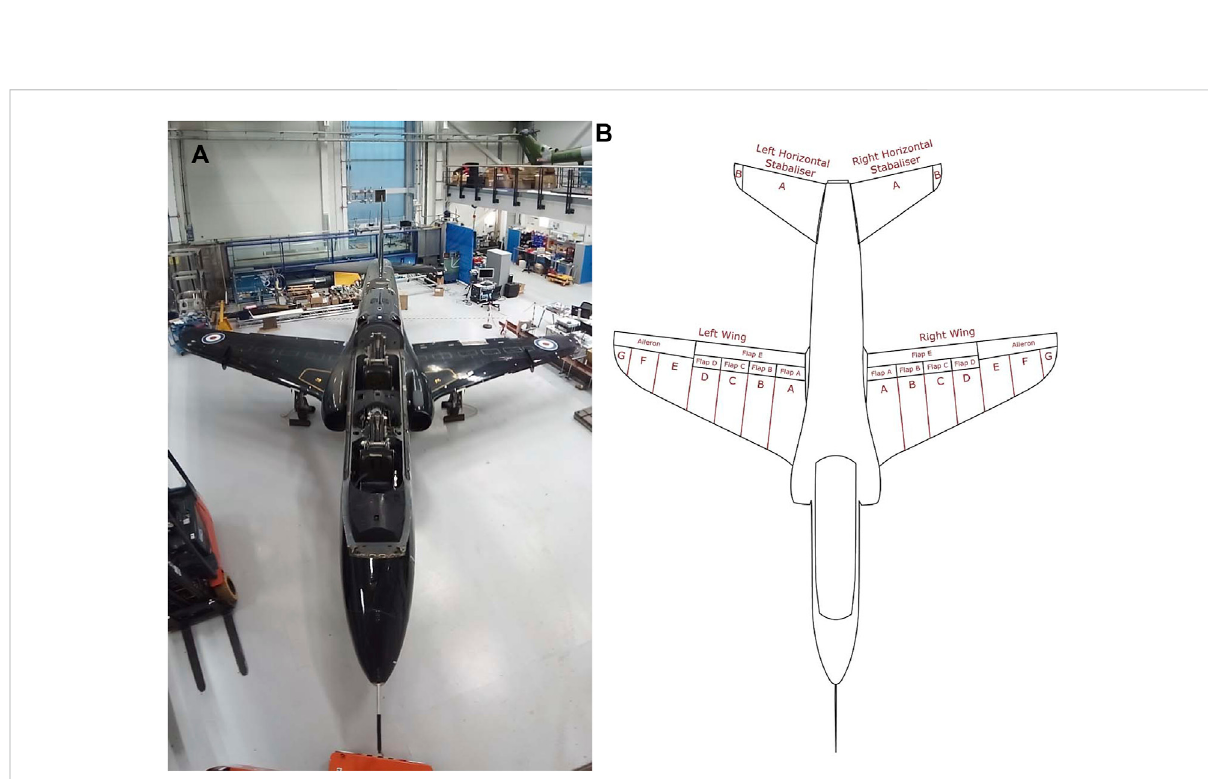
FIGURE 4 (A) PhotoofthetopdownviewoftheHawkT.Mk1attheLaboratoryforVeri fi cationandValidation. (B) IrreducibleElementmodelbreakdownof the wing and horizontal stabiliser sections of the Hawk T.